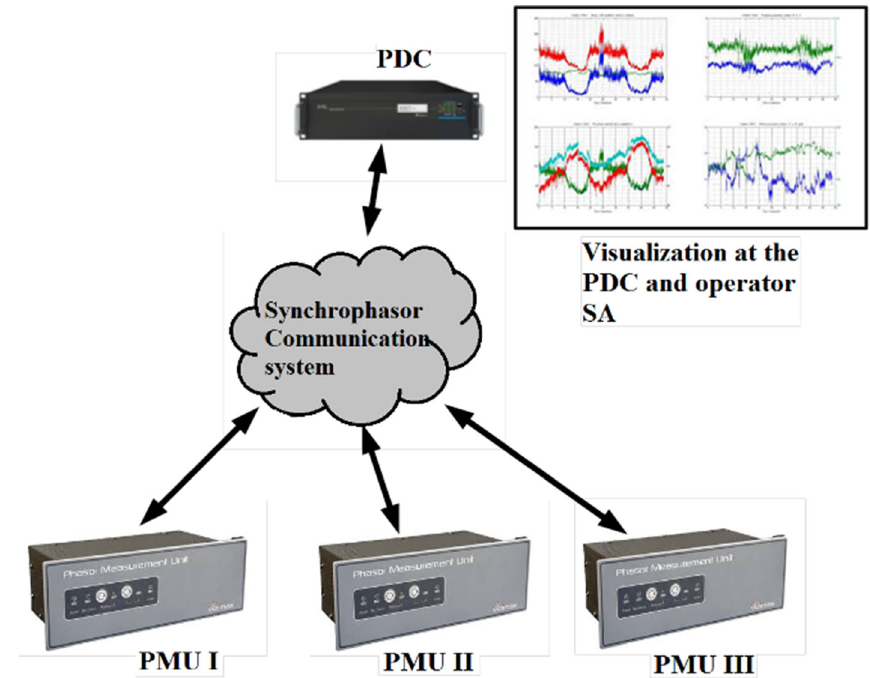
Fig. 1 Synchrophasor communication system and the operator